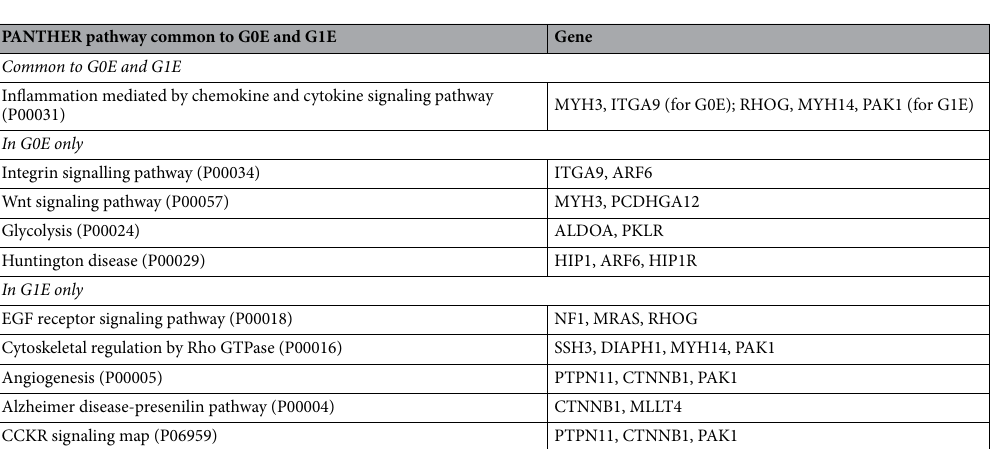
Table 3. List of pathways identified by Panther classification system analysis (PANTHER software, release 17.0) for the proteins exclusively expressed in G0E and G1E.